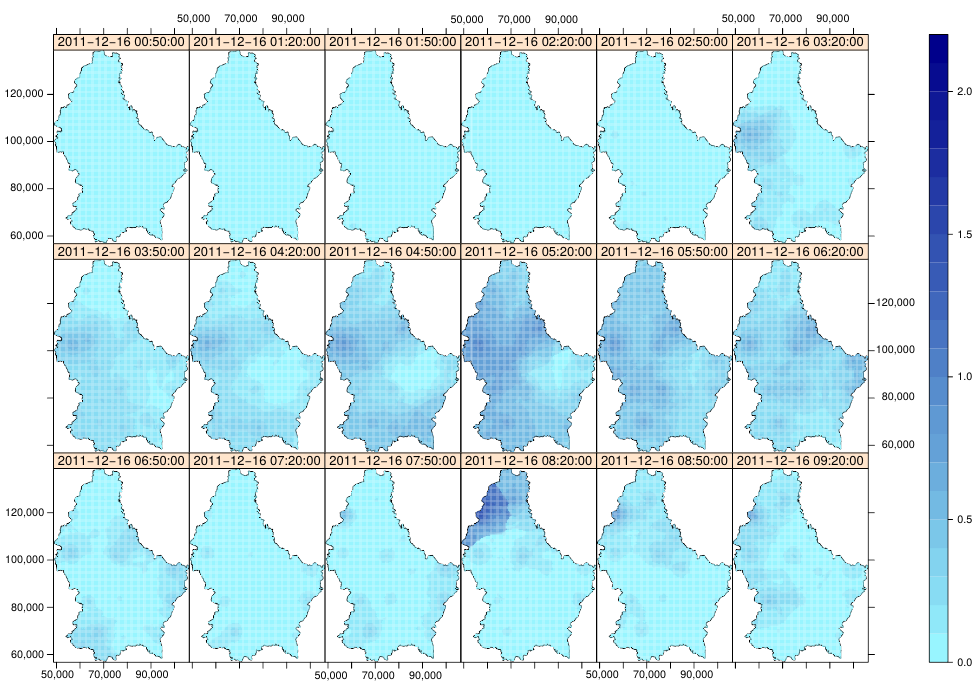
Figure 9. Predictions obtained with the spatio-temporal sum-metric model (lower boundary of the 90 percent prediction interval).